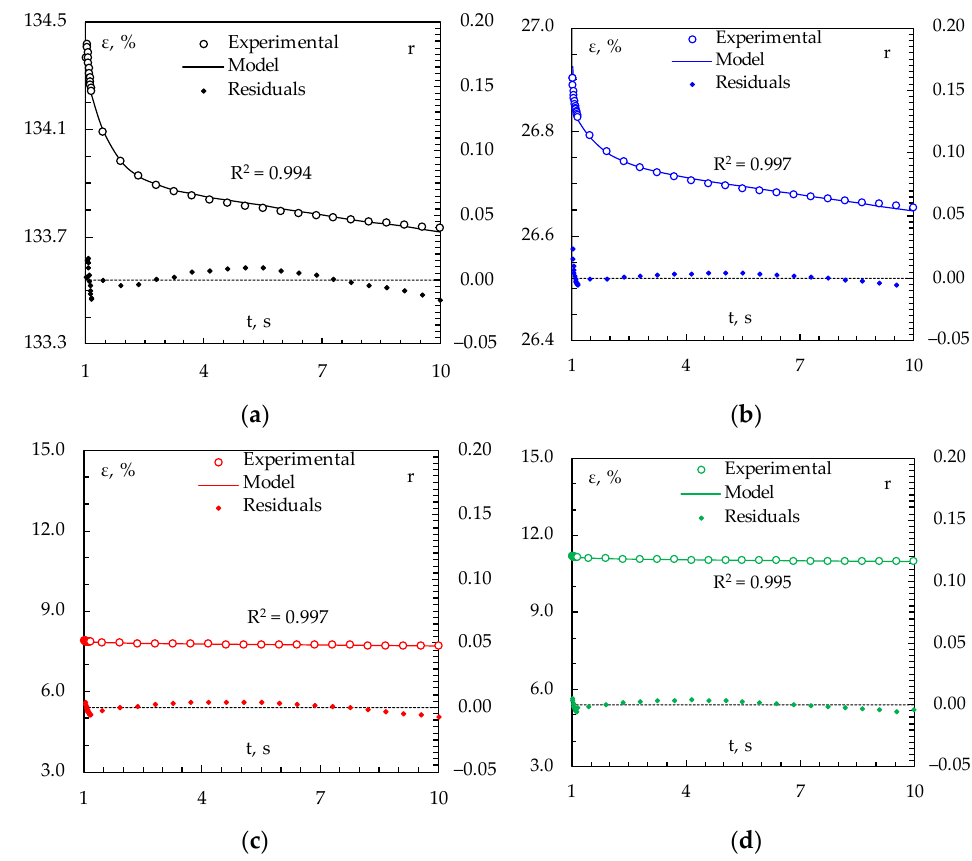
Figure 6. Fractional model (recovery phase): BIT ( a ), MAS-L ( b ), MOR-L ( c ) and MOR-S ( d ) at 60 °C, 0.1 kPa. Table 5. Fractional model fitting coefficient for all materials and test conditions.